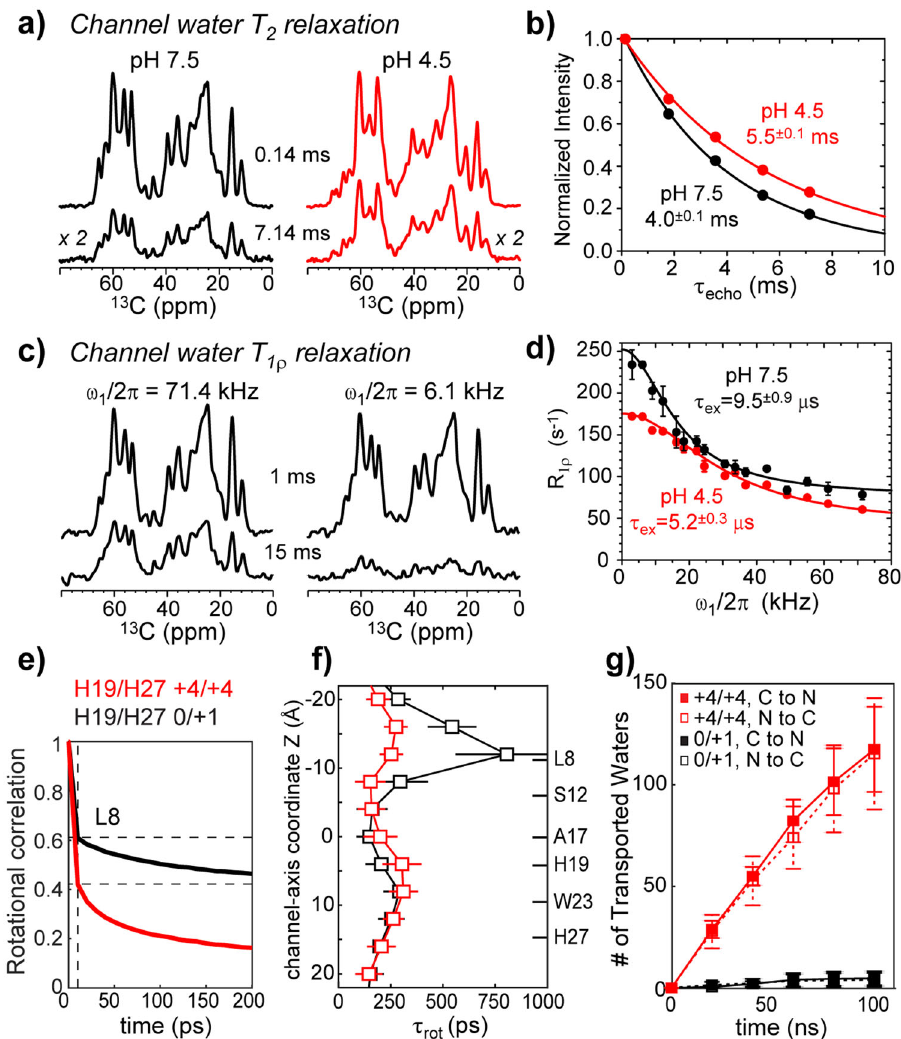
Fig. 3 Rotational and translational diffusion of water in BM2 channels. a Representative 13 C-detected NMR spectra probing water 1 H T 2 ′ at pH 7.5 and pH 4.5. These spectra were measured with total echo delays of 0.14 ms and 7.14 ms. b Channel-water 1 H T 2 ′ relaxation decay curves. T 2 ′ relaxation is slower at low pH (red) than at high pH (black), indicating that the low-pH water has faster rotational dynamics. c Representative 13 C-detected NMR spectra of high-pH BM2 probing channel-water R 1 ρ relaxation. The spectra were measured with spin-lock times of 1 ms and 15 ms and spin-lock fi eld strengths of 71.4 kHz (left) and 6.1 kHz (right). d On-resonance 1 H R 1 ρ relaxation dispersion pro fi les of water in the pH 7.5 (black) and pH 4.5 (red) channel. The low-pH channel shows a shorter τ ex than the high-pH channel. Error bars for R 1 ρ values are the standard deviation of the fi t for the signal decay at each spin-lock strength. e Simulated rotational correlation decay curves of waer near L8 in the closed and open channels. A fast decay in ~10 ps followed by a slower decay in ~500 ps is seen, and is representative of all water near protein residues. f Slow-component water rotational correlation times along the channel axis for closed and open BM2 channels. In the open state, water near H19 has the longest τ rot . In the closed state, water near L8 has the longest τ rot . g Total number of water molecules transported across the channel in both directions for the high-pH and low-pH states. Error bars for simulations are the standard error of the mean for four independent